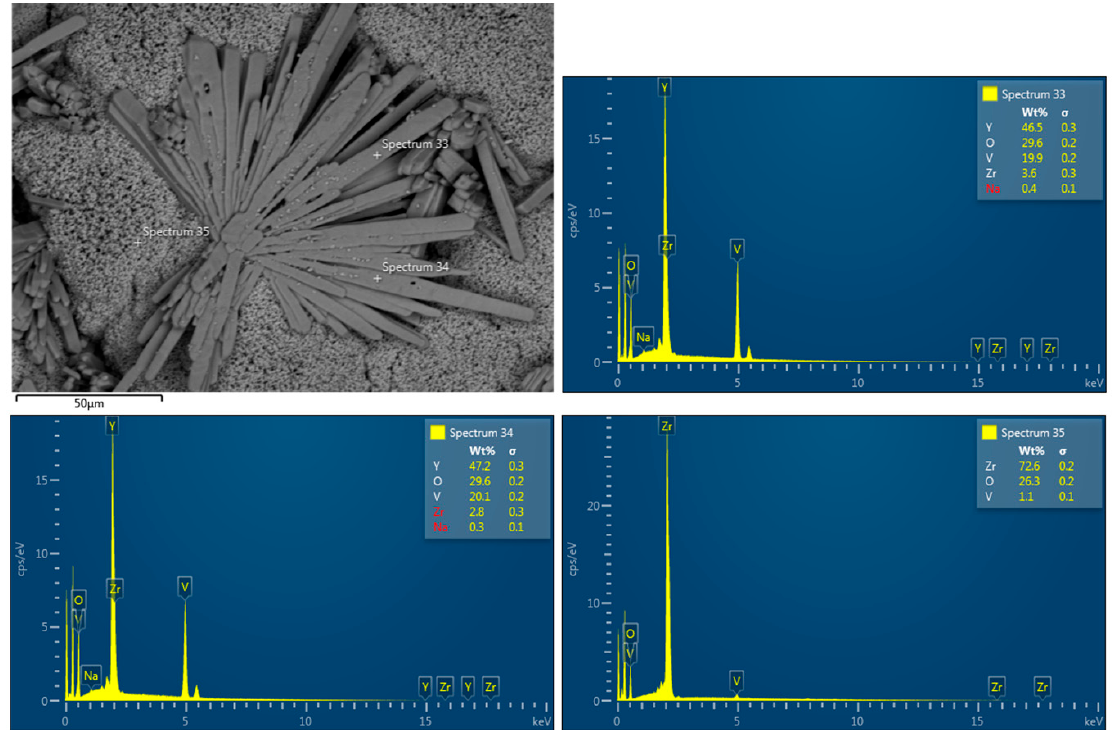
Figure 5. Surface microstructure with EDS analysis of YSZ TBC after the hot corrosion test.